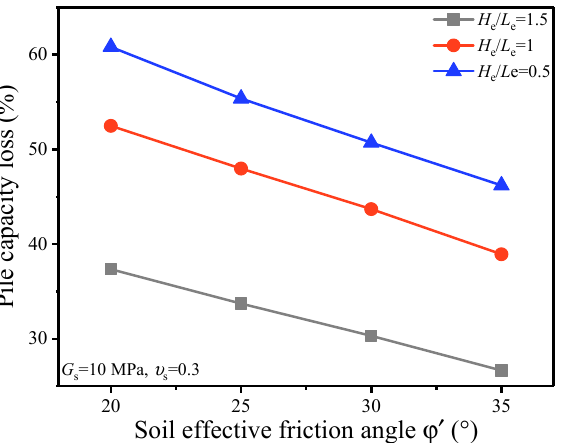
Figure 14. Effects of soil effective friction angle on pile uplift capacity loss with various ratios of excavation depth to effective pile length.